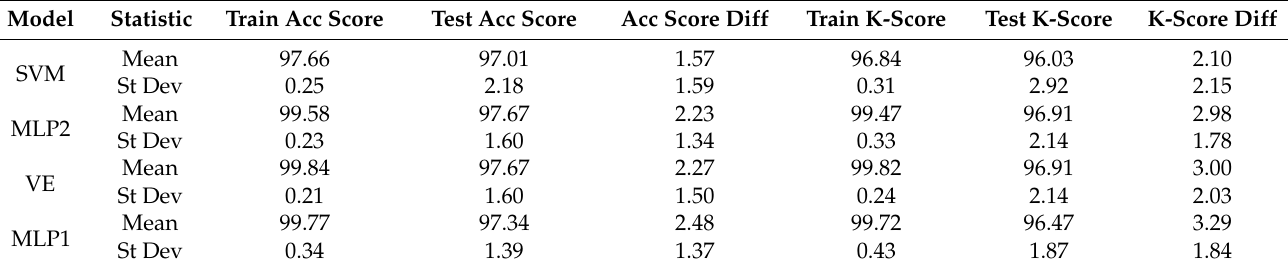
Table 3. Cross-validation summary scores across all 10 folds.